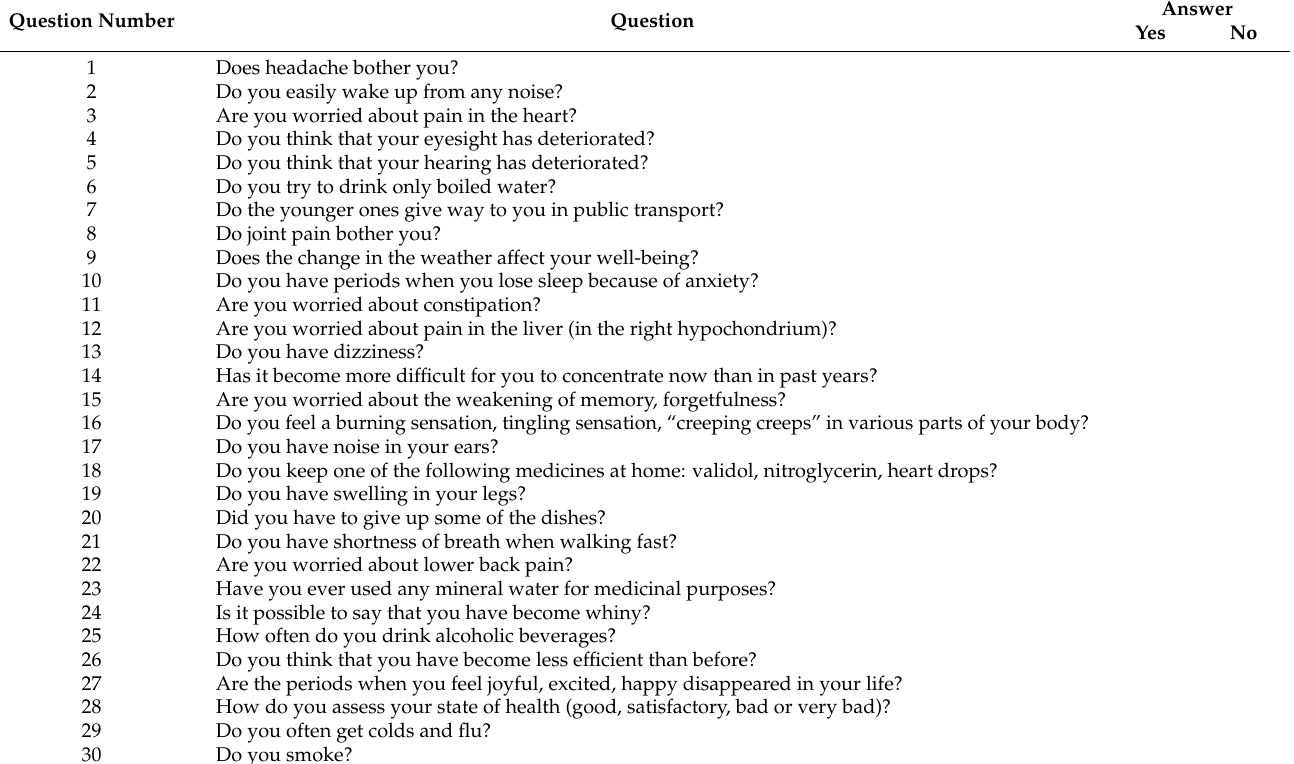
Table A1. Health Self-Assessment